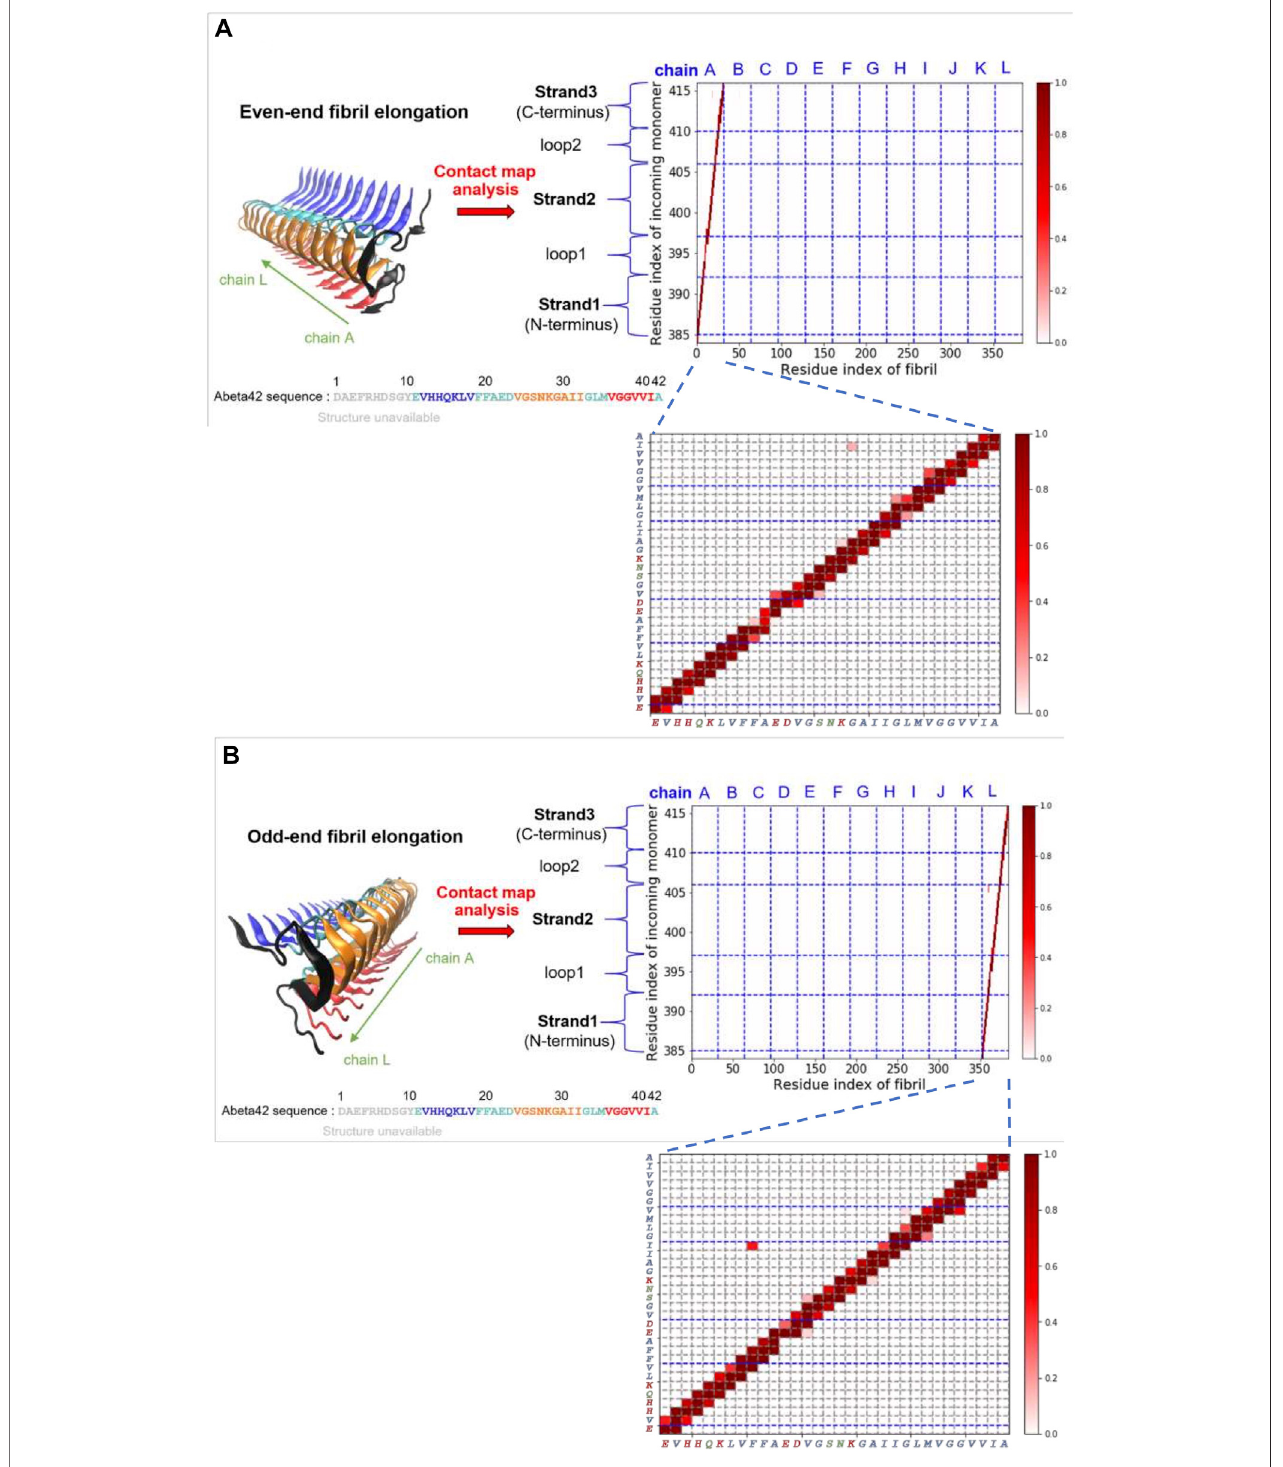
FIGURE 4 | Fibril elongation with the monomer being in the activated fi bril-like conformation and their contact maps are shown. (A) Even-end fi bril elongation. (B) Odd-end fi bril elongation.